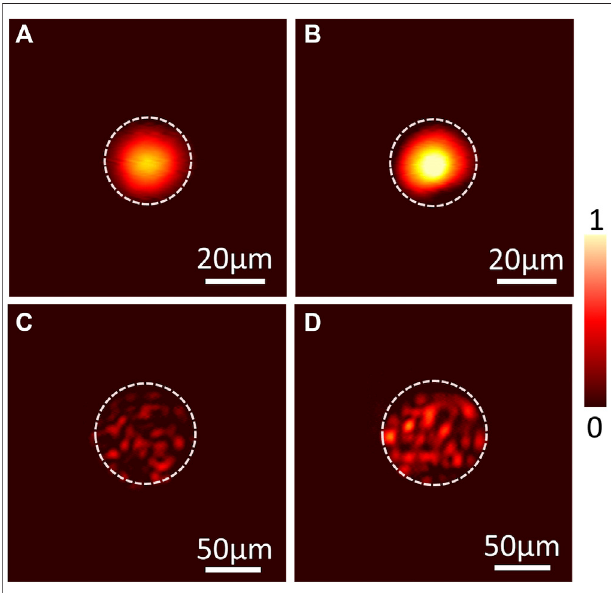
FIGURE 3 | The images of the spread of the light in (A) the bulk and (B) waveguide of the phosphate glass.